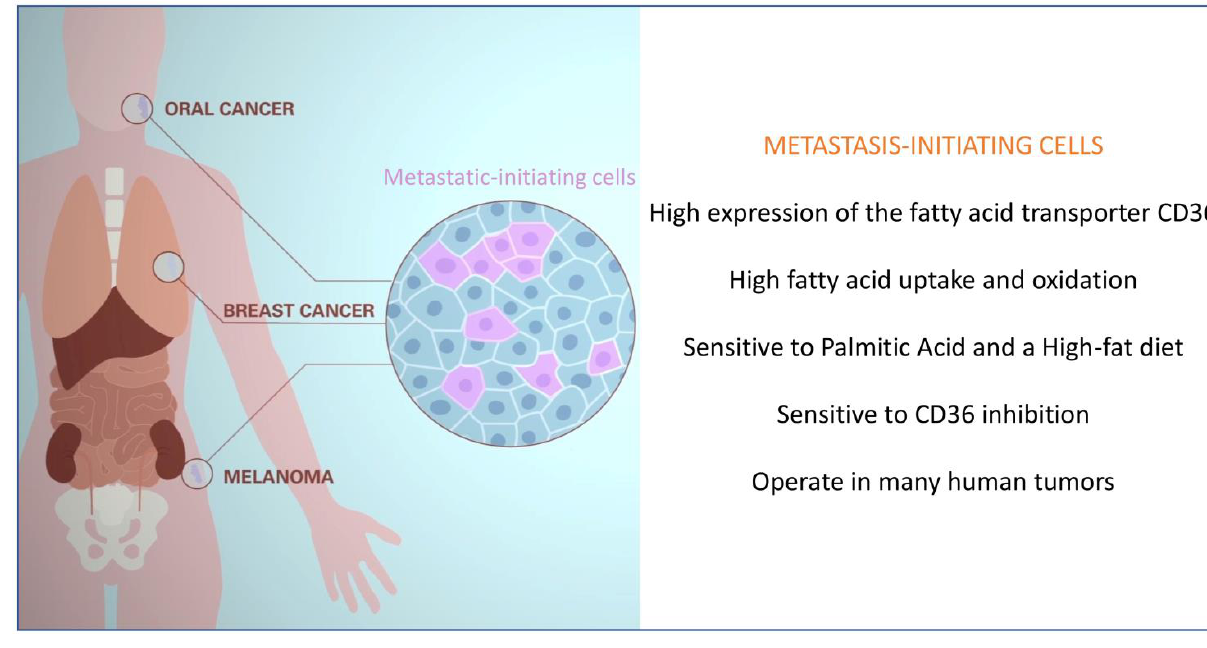
FIGURE 1 : Diagram summarizing key aspects of metastatic-initiating cells identified in a variety of human tumours. Metastatic-initiating cells are characterized by their high expression of the fatty acid transporter CD36 and a prominent lipid metabolism. This makes metastatic cells highly responsive and sensitive to dietary fatty acids, such as palmitic acid, and dependent on the activity of CD36 to metastasize to dif- ferent organs ( i.e. lymph nodes, lungs, liver,